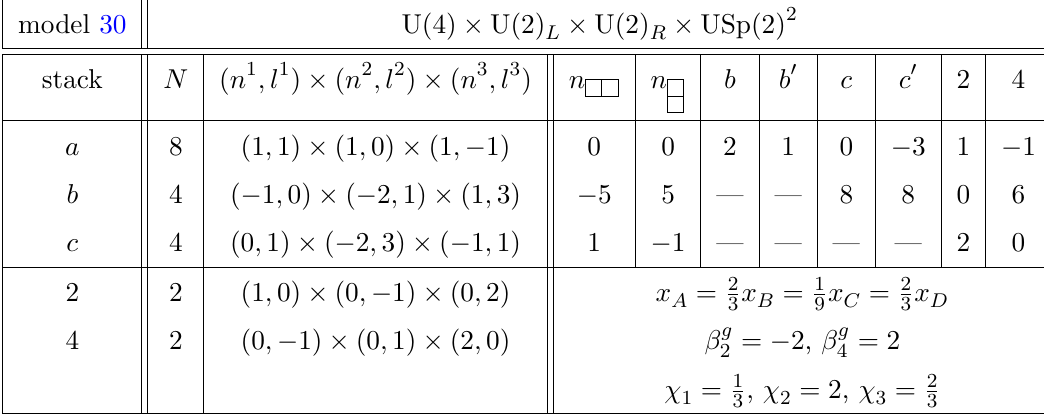
Table 30 . D6-brane configurations and intersection numbers of Model 30, and its MSSM gauge